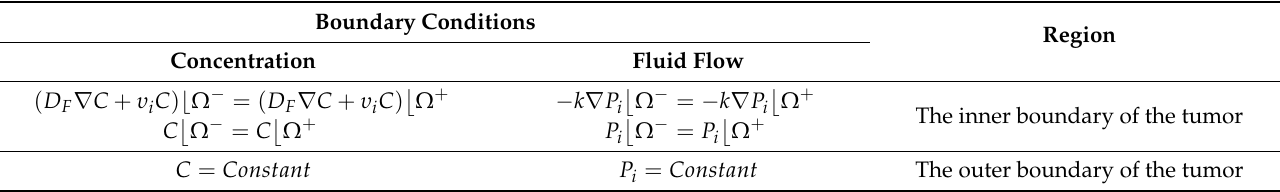
Table 3. Boundary conditions employed for the present model.